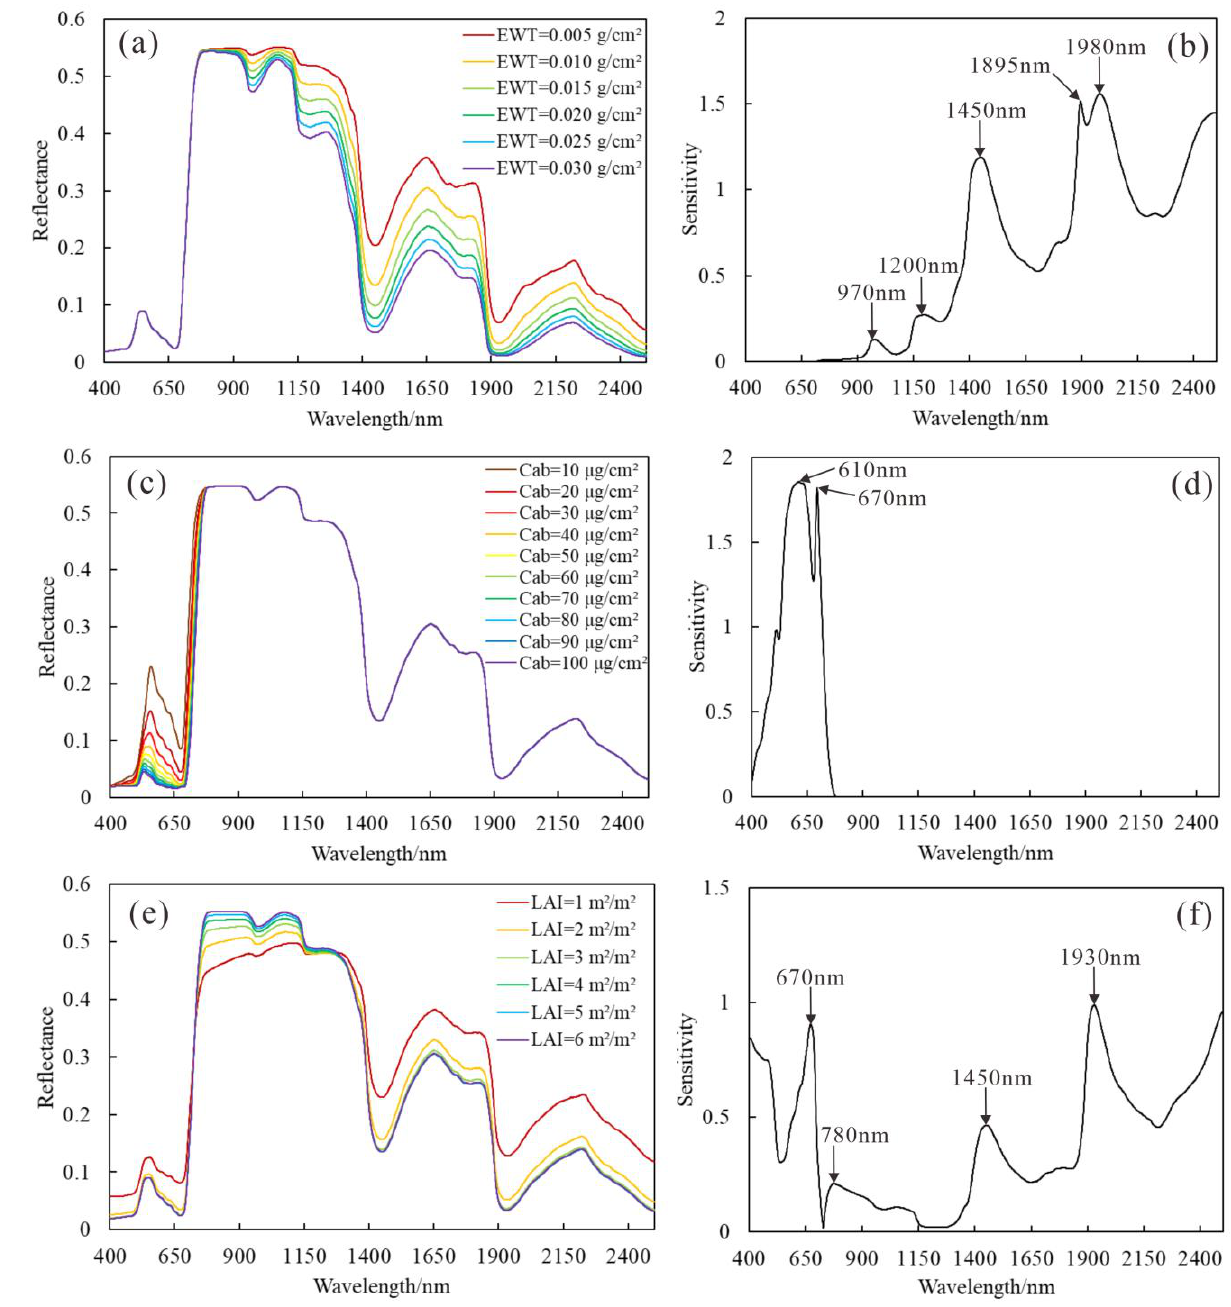
Figure 3. Spectral reflectance of plant canopy simulated by the PROSAIL model. ( a ) Simulated spectral reflectance under different EWT; ( b ) sensitivity analysis of EWT; ( c ) simulated spectral reflectance under different Cab; ( d ) sensitivity analysis of Cab; ( e ) simulated spectral reflectance under different LAIs; and ( f ) sensitivity analysis of the LAI.